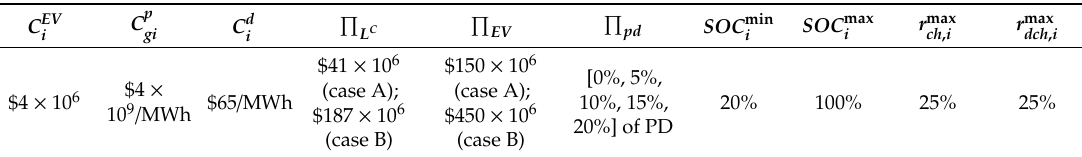
Table 1. Settings of parameters.